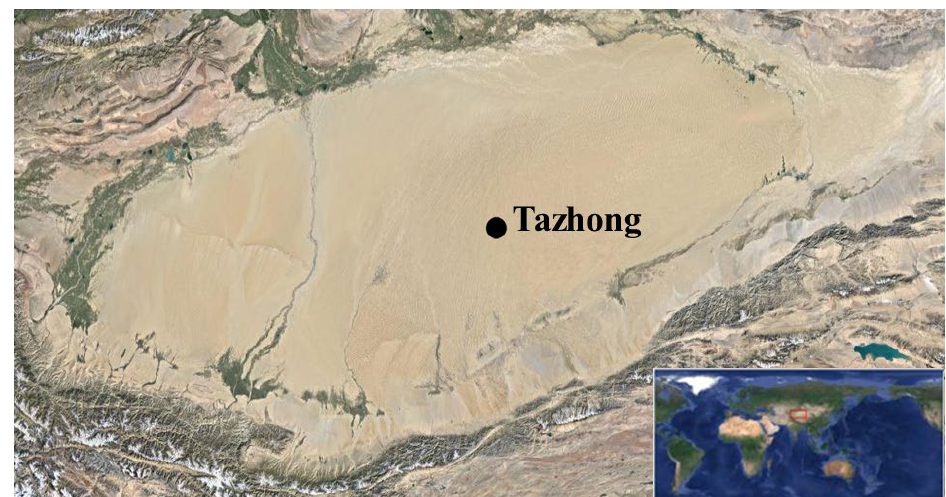
Figure 1. Location of the experimental site in the Taklimakan Desert.